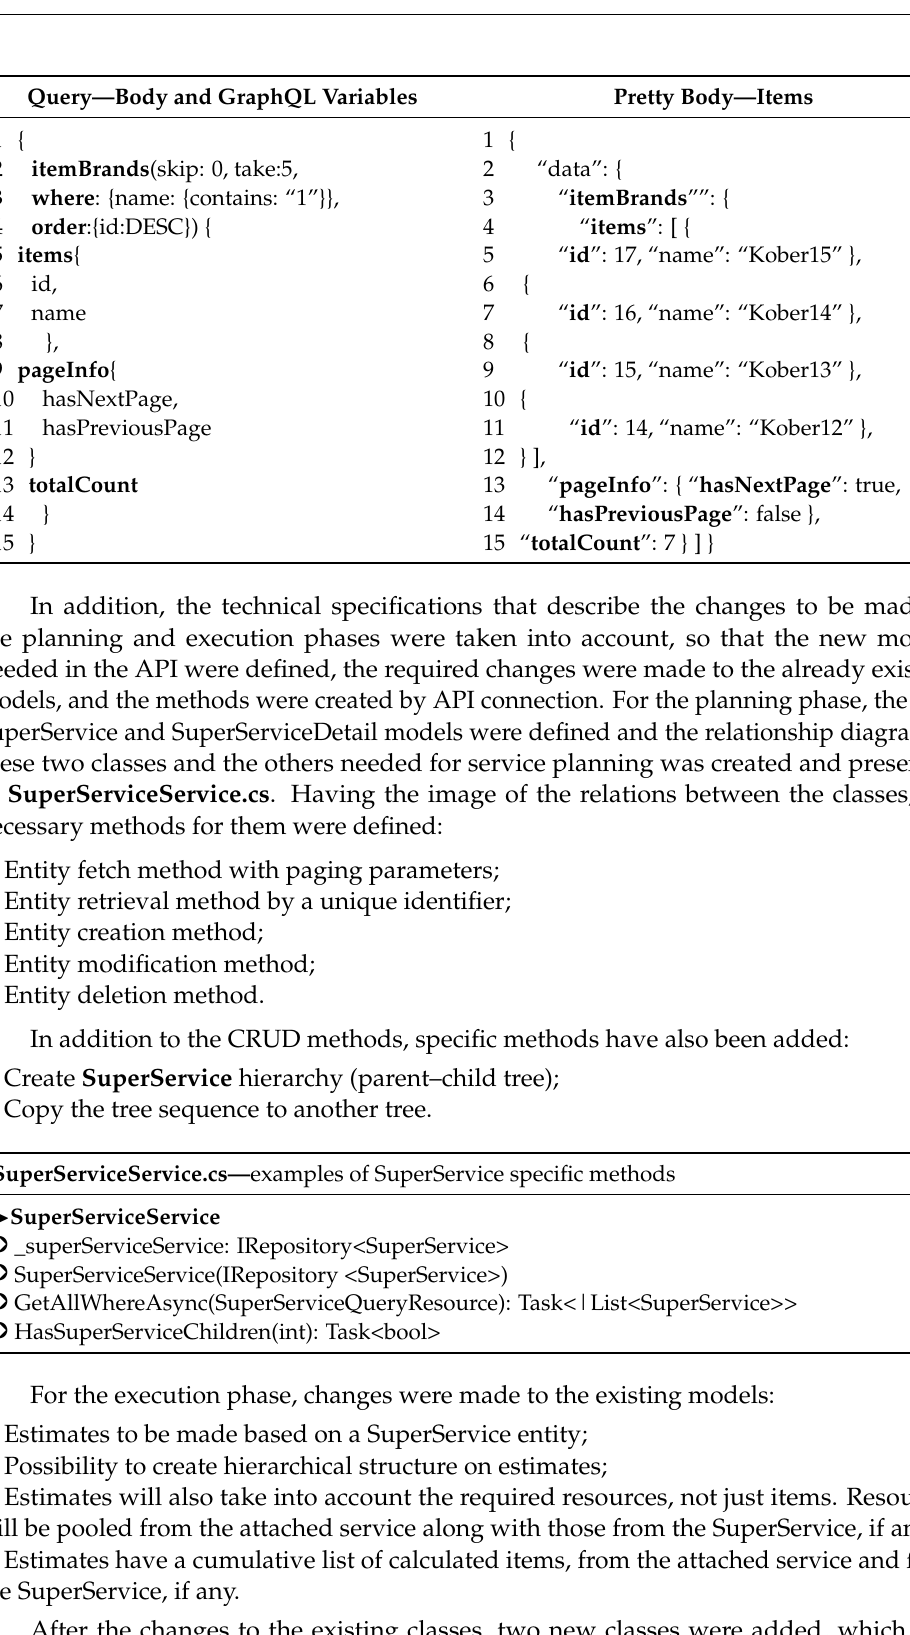
Algorithm 2: Database modification process in relation to the described models. Expan- sion of the database depends on the need to use the SuperService entity in order to cal- culate the estimates.